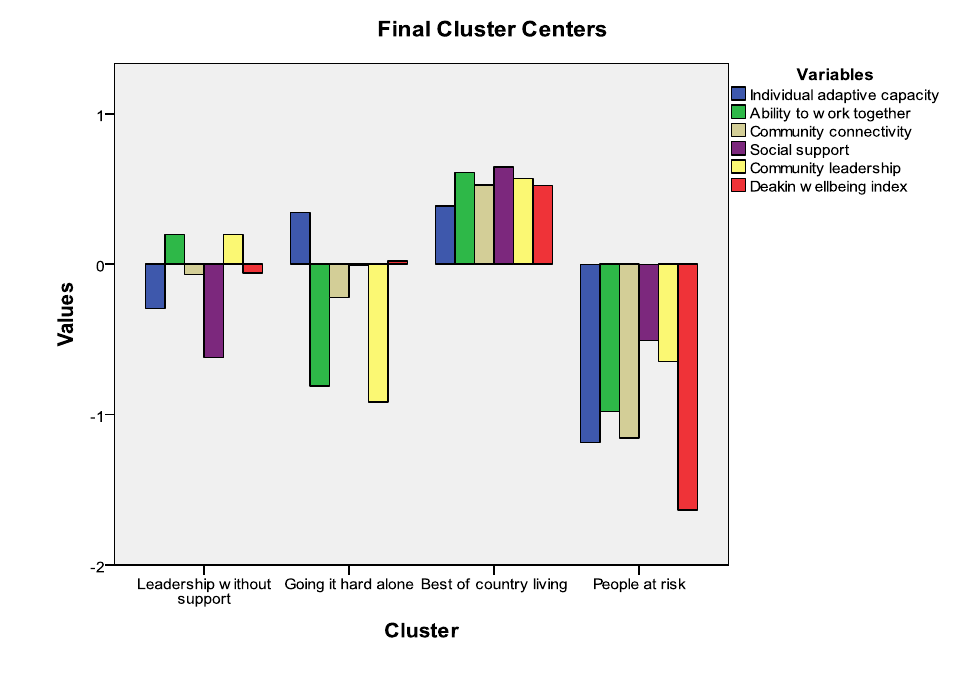
Figure 2. Visual presentation of the 4-cluster solution.